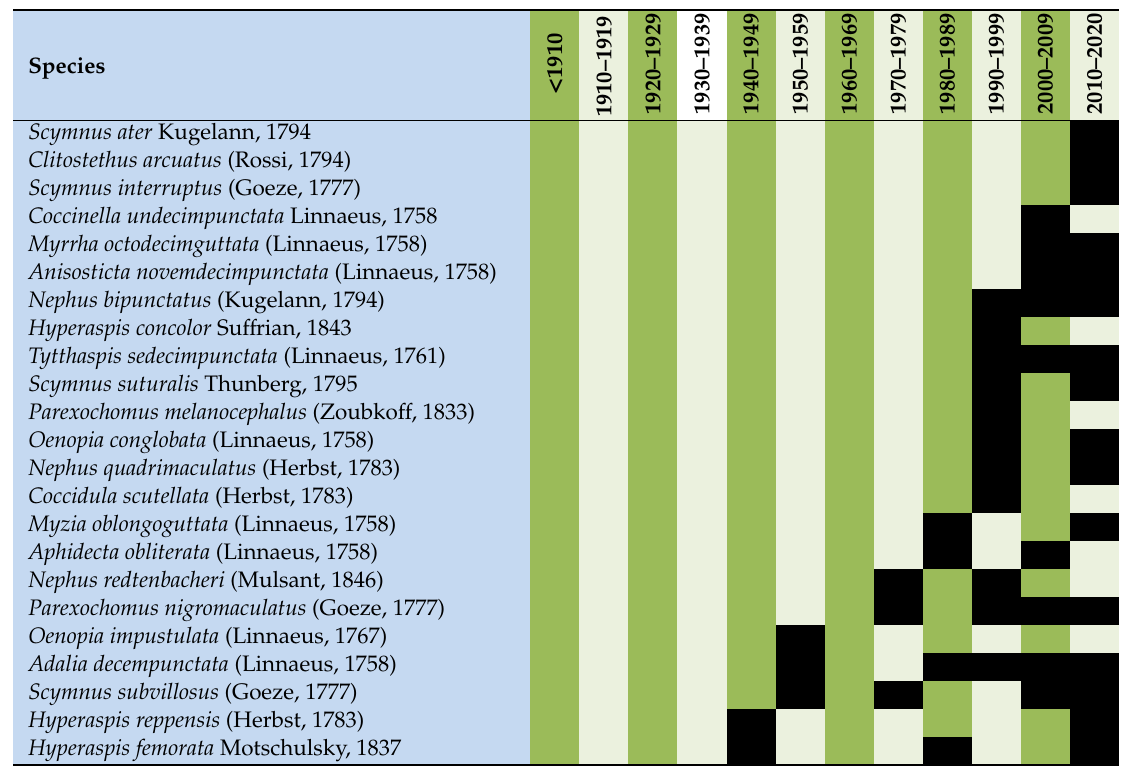
Table 2. The ladybird species appearing in the region during resort development. The decades when the species were detected are shaded with black. The species are arranged in the reverse chronological order of their first